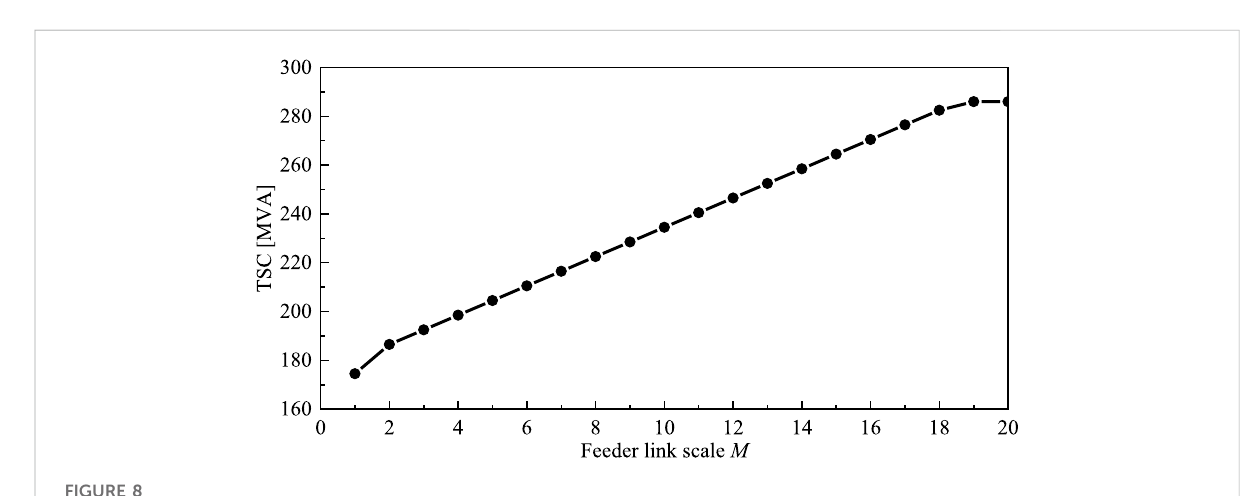
FIGURE 8 TSC increase with feeder link scale ( M ) of optimal construction order of case